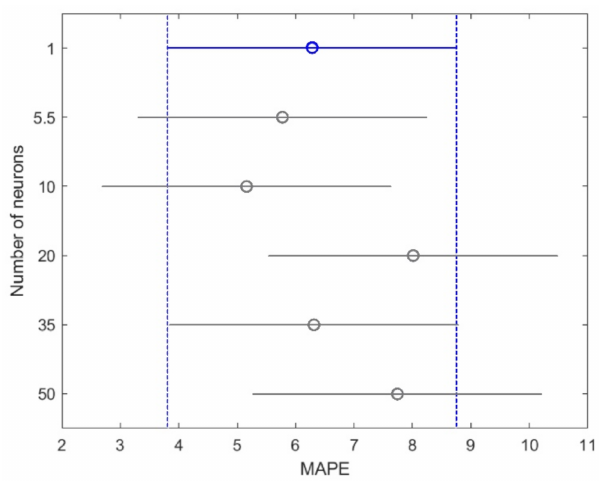
Figure 6. Multi-comparison test: MAPE vs. number of neurons.